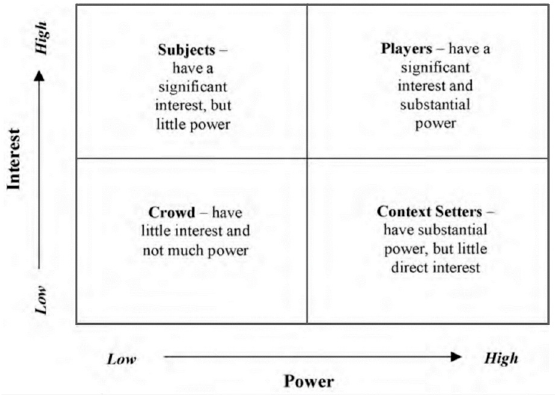
Figure 6. The power versus interest grid (Eden and Ackermann 1998, p. 122).